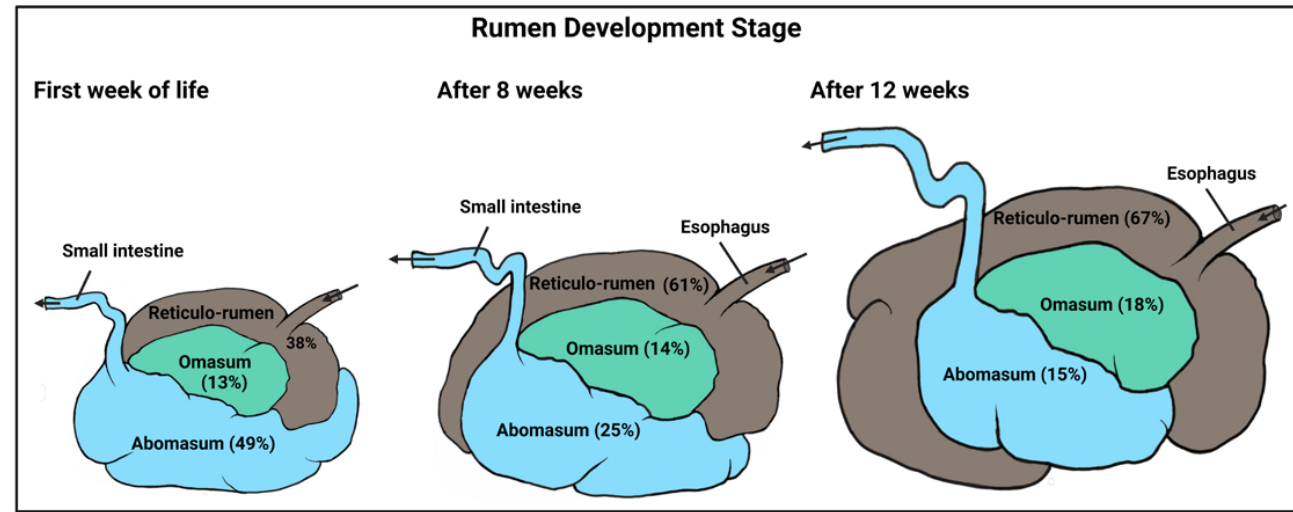
Figure 2. Transitioning of ruminant digestive system from early life to maturity [23]. Rumen development can be categorized into three phases: (i) non-rumination phase (from birth to 21 days), (ii) transitional phase (from 21 to 56 days), and (iii) rumination